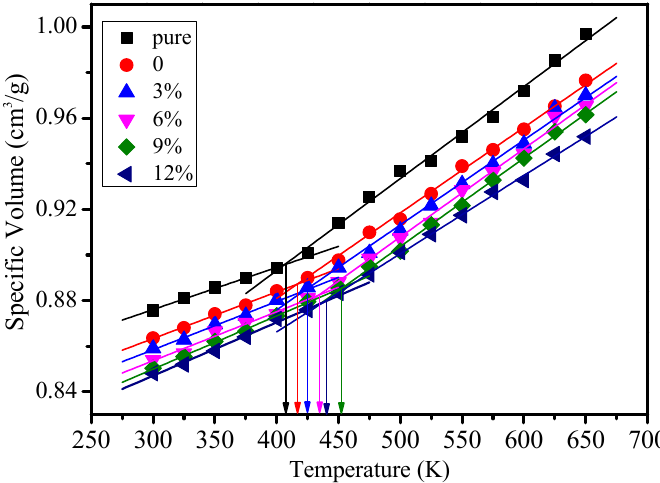
Figure 4. Specific volume value of different models at different temperatures.